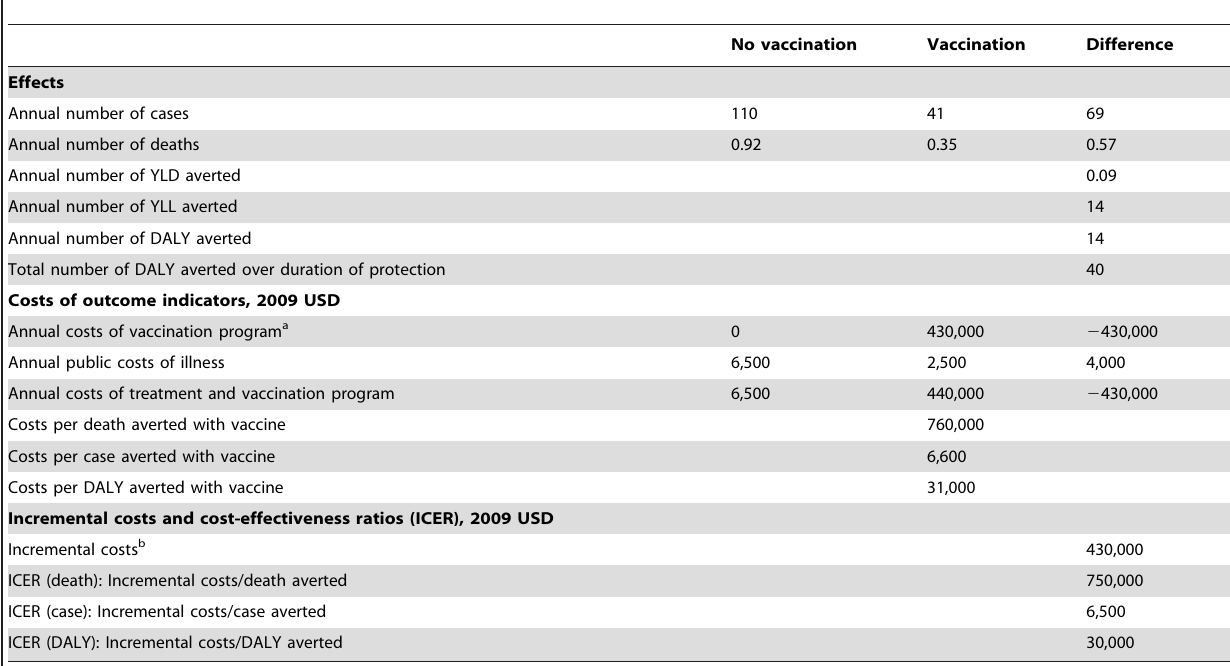
Table 6. Key outcomes from model of mass oral cholera vaccination (health care provider perspective) in Zanzibar,